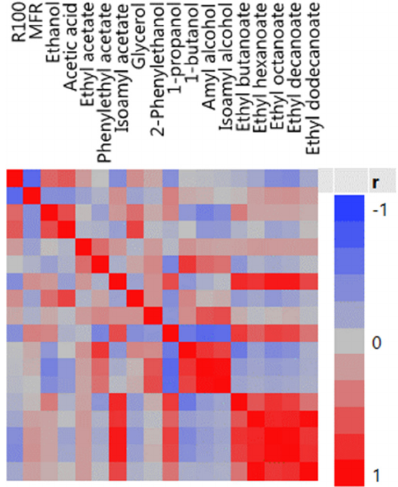
Figure 3. Correlation map of the 18